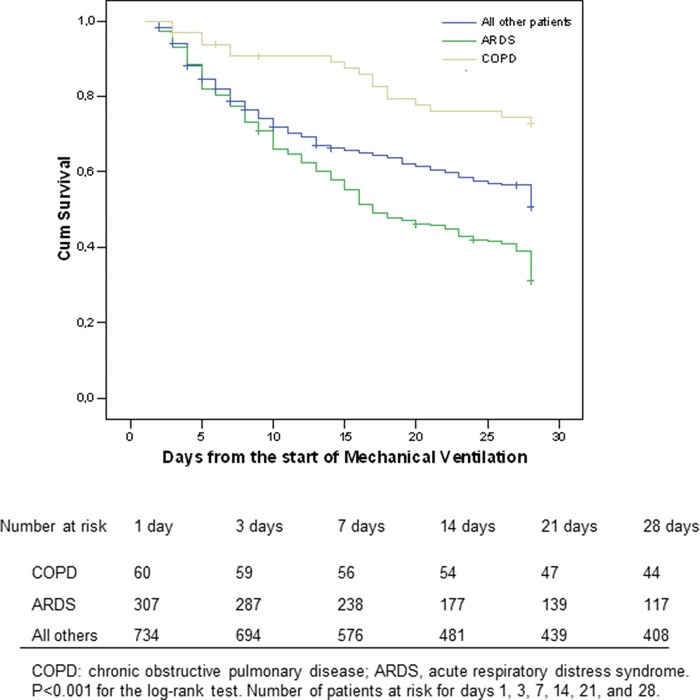
Figure 1. Kaplan-Meier curves of the probability of survival over time for mechanical ventilation.